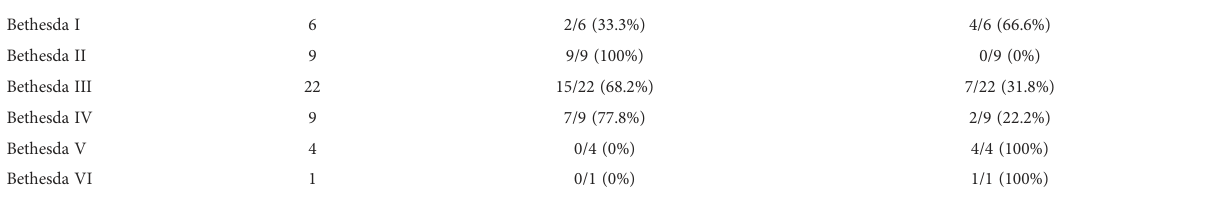
TABLE 1 Traditional cytology reports vs. post-surgical histology.